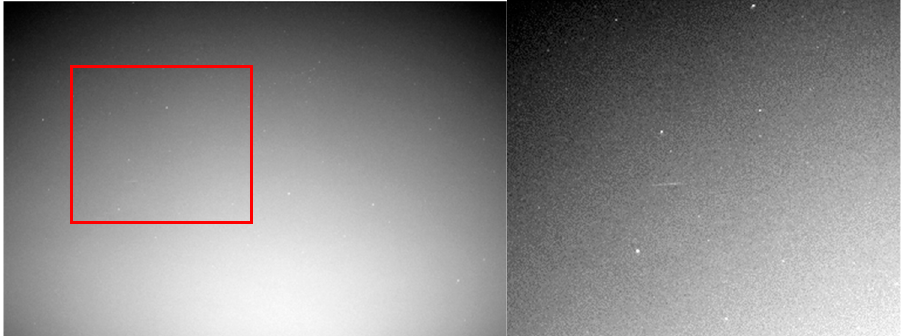
Figure 5. Captured image, converted to grayscale, showing an unevenly lit background. On the right side a detail of the full image is shown, with the faint satellite streak.